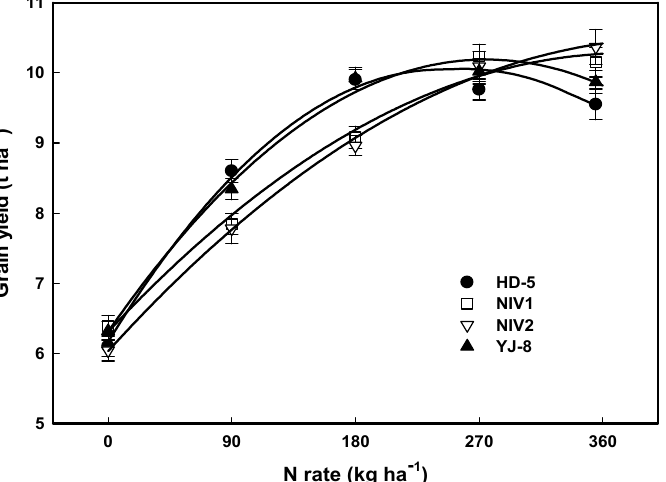
Figure 1. Yield response curve to nitrogen application rate of different rice varieties with the nitrogen proportion of 4:2:2:2 at different applied stages. HD-5, Huaidao 5; YJ-8, Yangfujing 8, NIV: N inefficiency varieties.